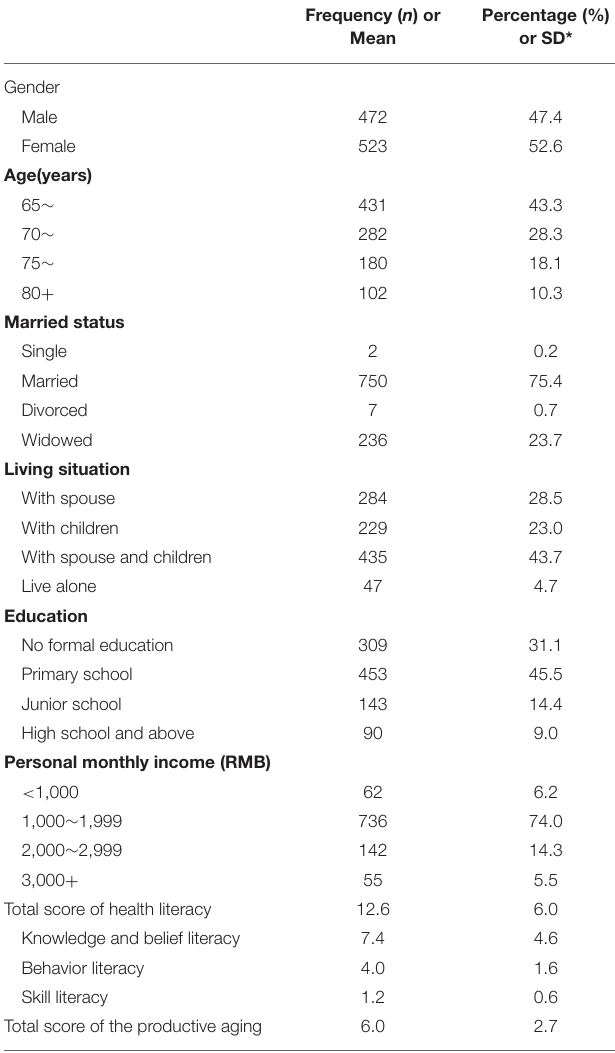
TABLE 2 | The characteristics of the participants ( n =